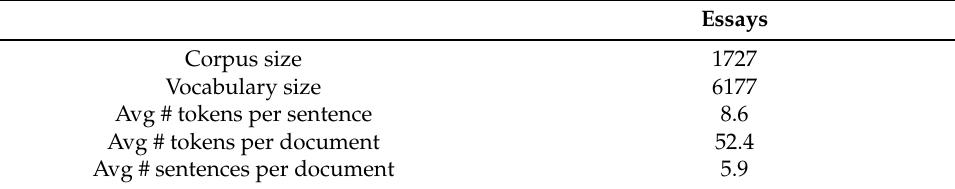
Table A3. Correlation task dataset